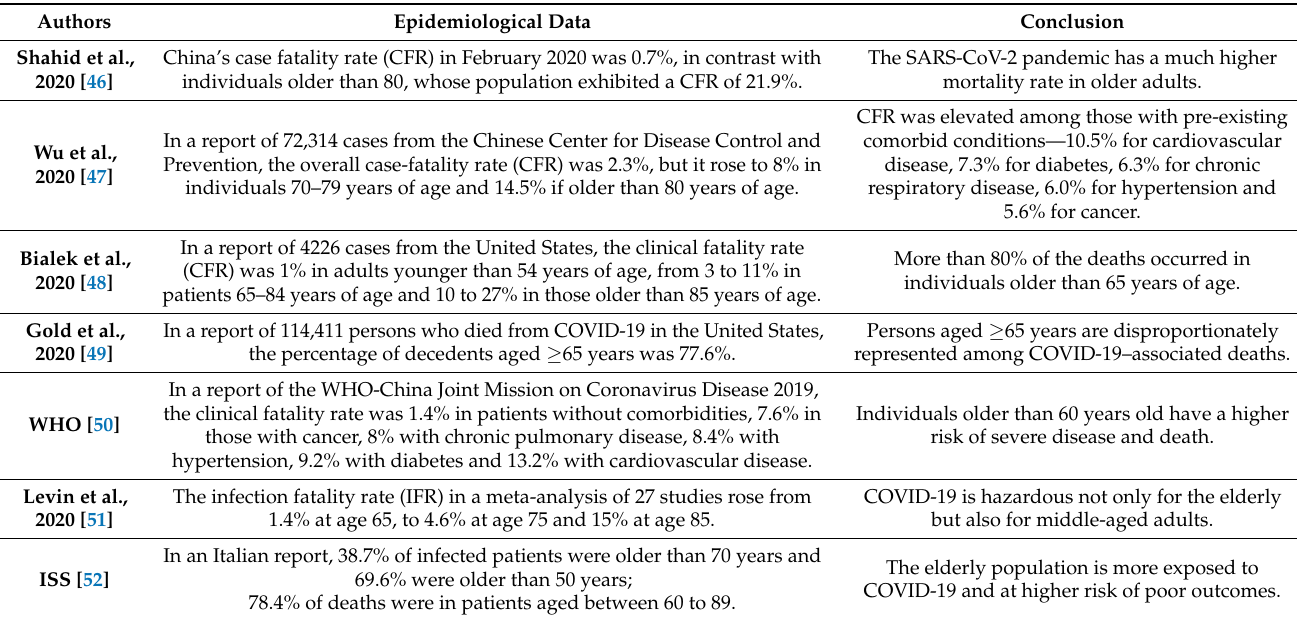
Table 1. Epidemiology of COVID-19 in older